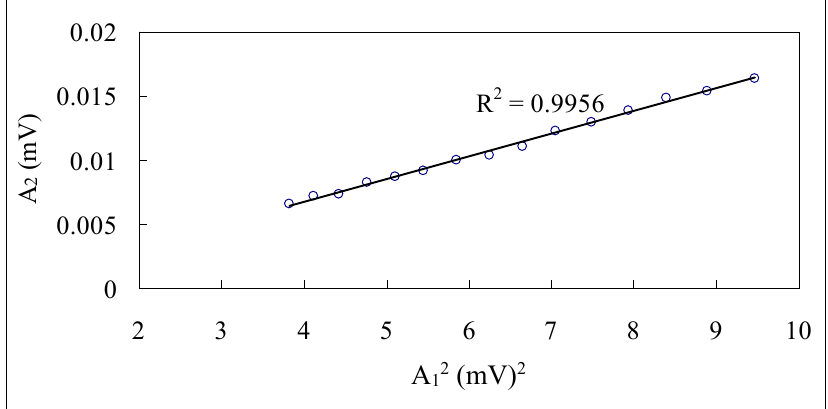
Figure 4. The amplitudes of the fundamental and second harmonics from the fast Fourier transform (FFT). Appl. Sci. 2020 , 10 , x FOR PEER REVIEW